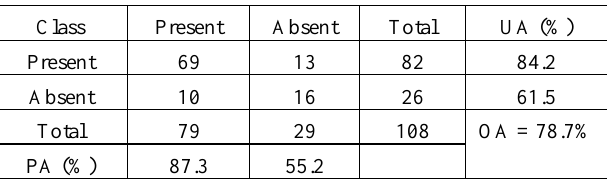
Table 6. Validation accuracies obtained by comparing field- based ground-truth sites with the classified image (bold figures indicated well-mapped